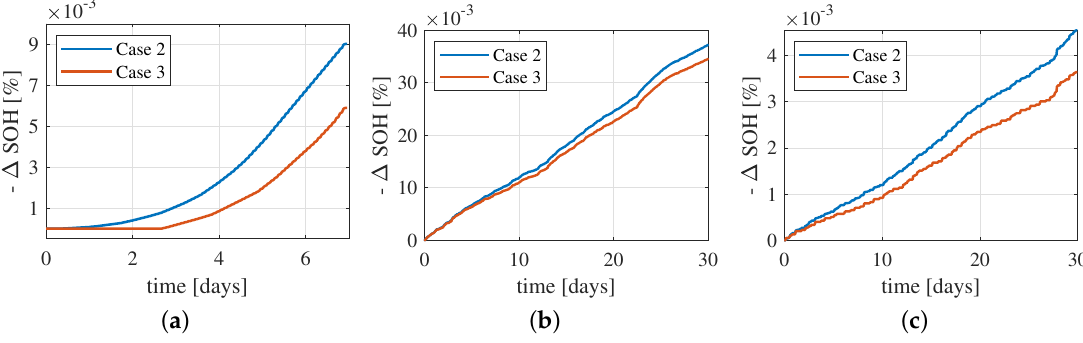
Figure A5. Ageing for: ( a ) Test data; ( b ) the intraday market; and ( c ) the day-ahead